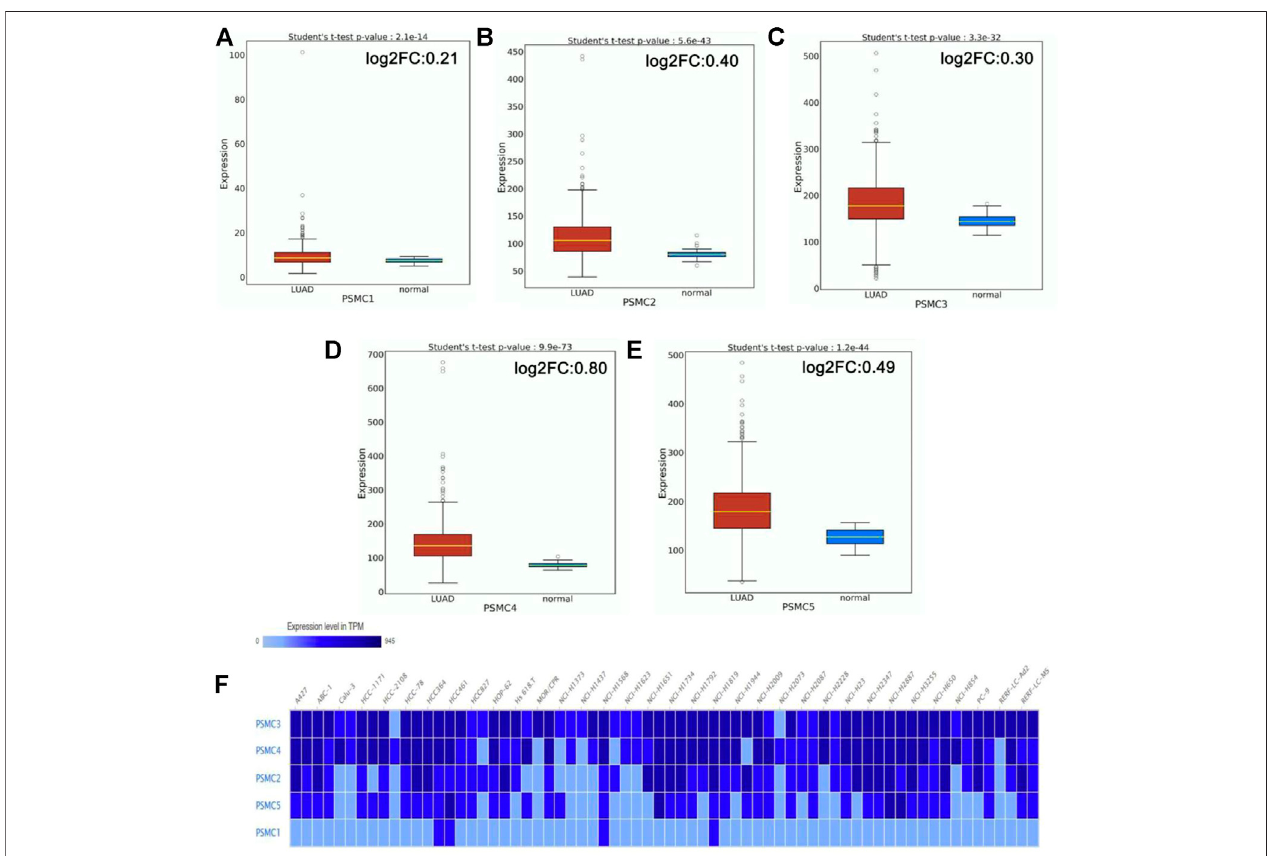
FIGURE 2 | mRNA level differential expression patterns of PSMC1 (A) , PSMC2 (B) , PSMC3 (C) , PSMC4 (D) , and PSMC5 (E) in normal lung and LUAD tissues observed from the OncoDB server. The expression values are presented in the TPM unit (log2 transformed). The red colored box represents LUAD samples, and the green colored box represents normal samples. The expression of the PSMC s in different LUAD cell lines (F) . The color gradient represents the expression value of PSMC s in TPM units in different cell lines, i.e., low intensity corresponds to a lower TPM and high intensity corresponds to a higher TPM, while the TPM value escalates with an increasing gradient from low to high. FC: fold